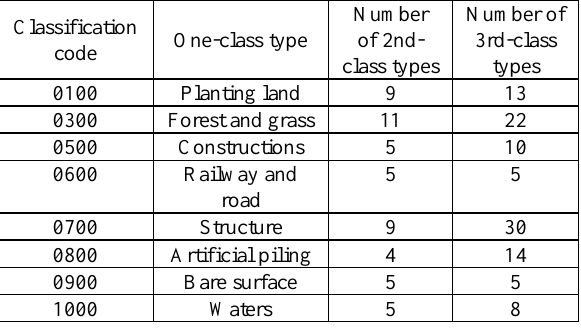
Table 1. Classification of monitoring contents